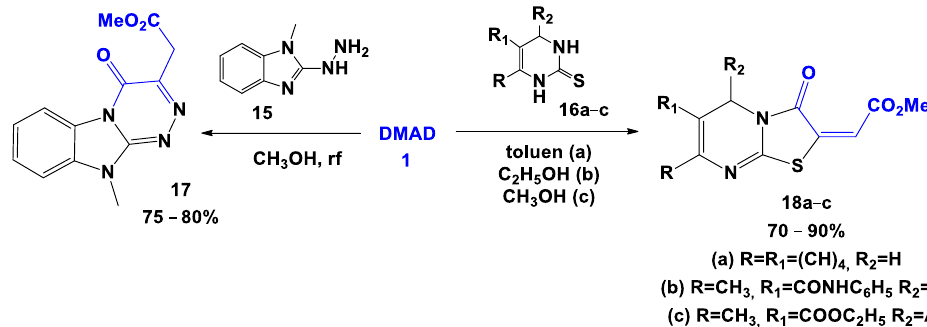
Scheme 2. Formation of cyclic products due to the “ nearest ” carboxyl